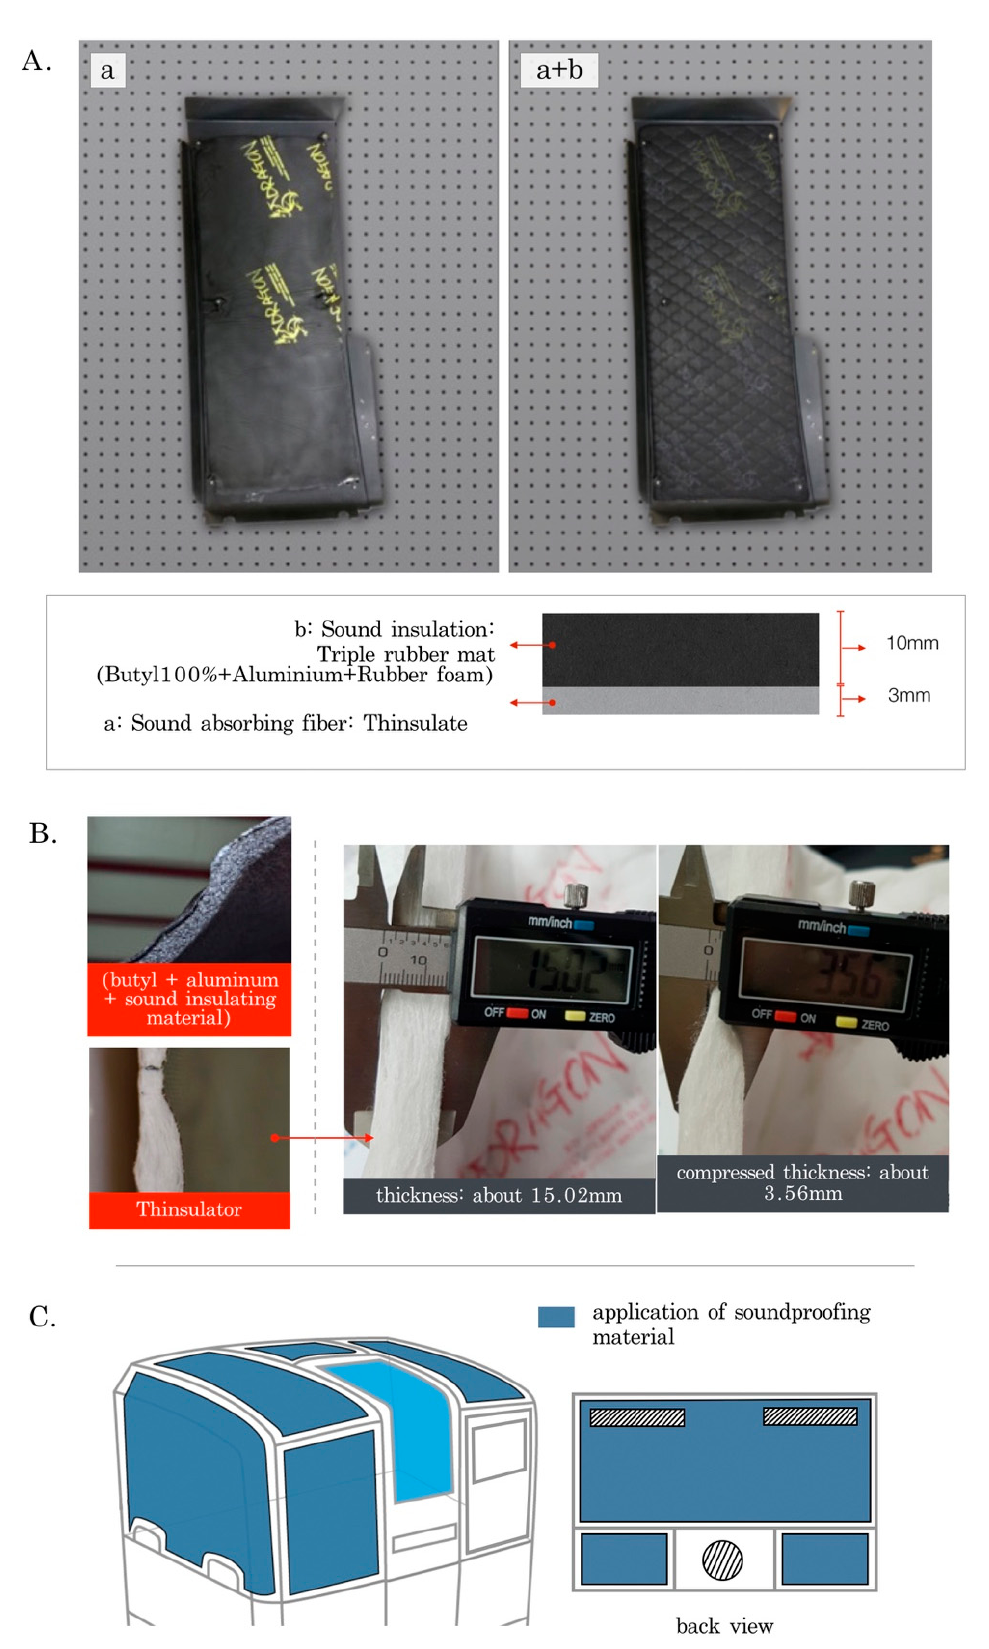
Figure 12. Optimal application of soundproofing materials to a milling machine. ( A ) the combination of Thinsulator and the triple-soundproofing; ( B ) thickness of each material; ( C ) the scheme of application.